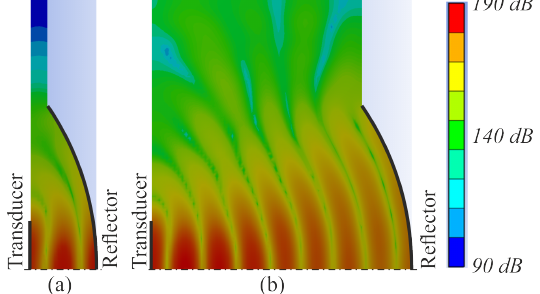
Figure 7. Sound field pattern between transducer and a concave reflector ( R = 72 mm) at distances of L 1 = 17.4 mm ( a ) and L 2 = 67.8 mm ( b ); maximum pressure level points marked with x; f = 21.4 kHz; ˆ x = 19 µ m.